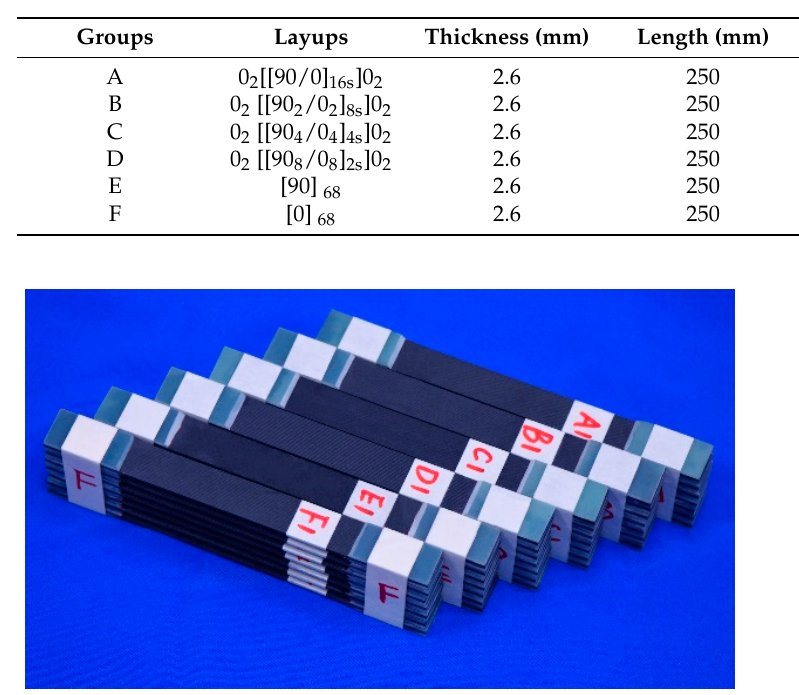
Figure 1. Image of the samples to be tested.